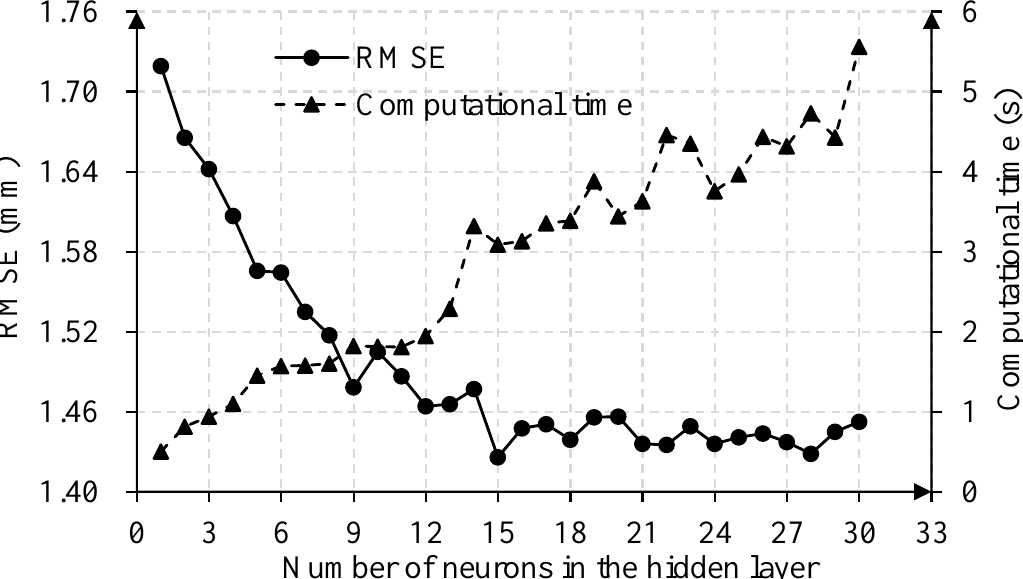
Figure 6. Exploration of the optimum number of neurons in the hidden layer.